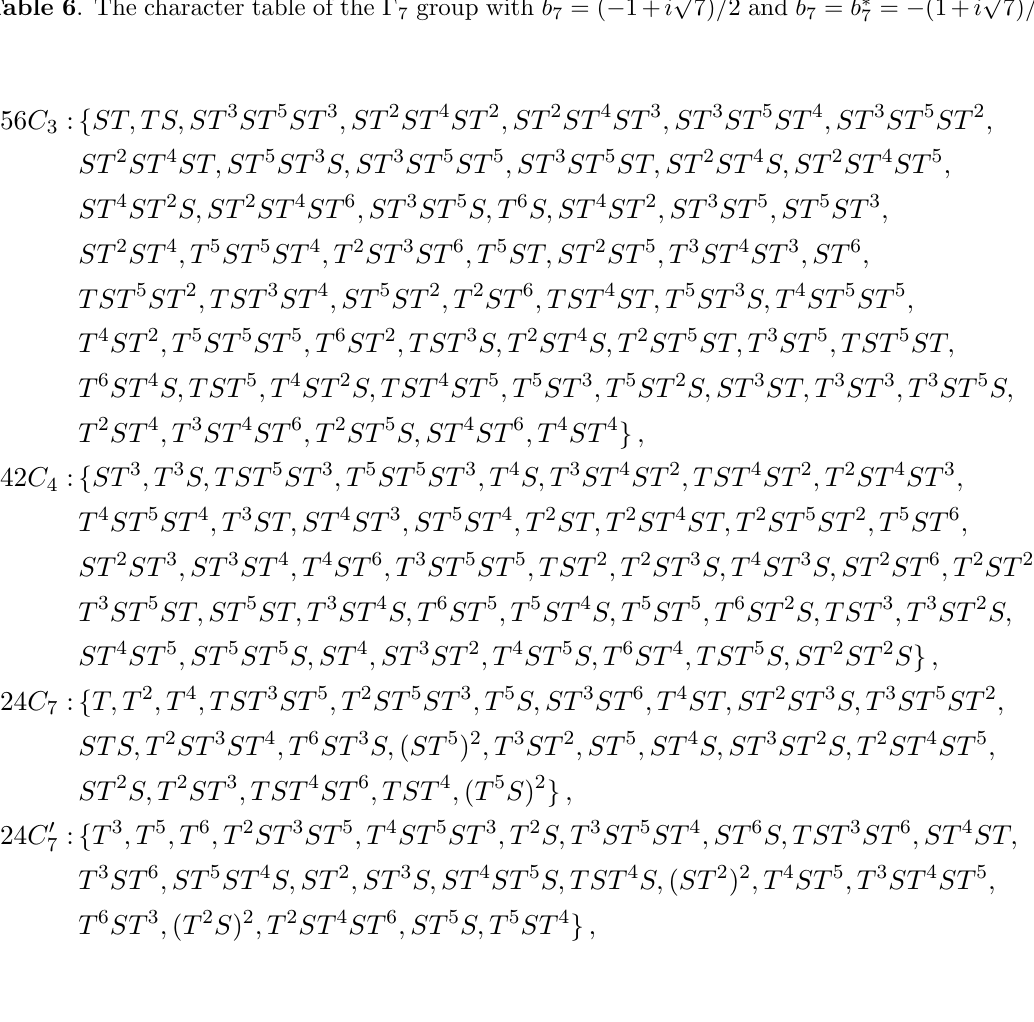
Table 6 . The character table of the (cid:0) 7 group with b 7 = ( (cid:0) 1+ i